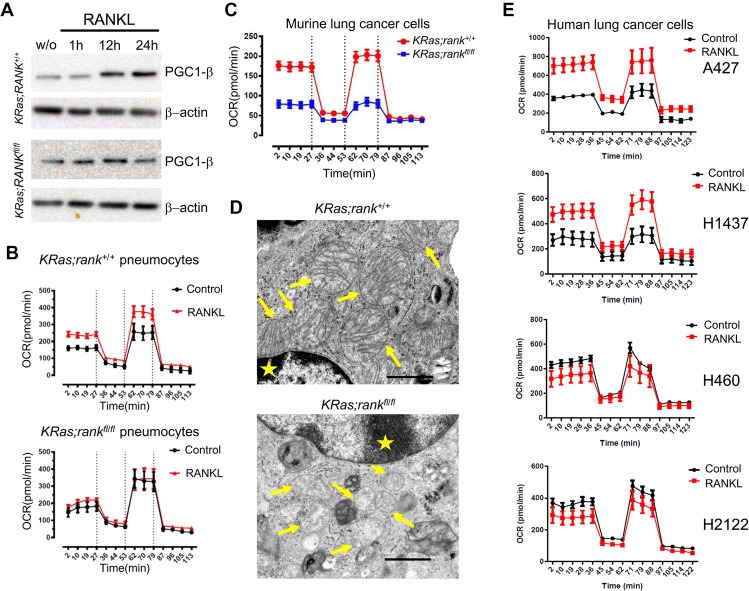
RANK couples to mitochondrial respiration. (A) Western blot analysis of pneumocytes isolated from KRas;rank+/+ and KRas;rankfl/fl mice treated for 96 h with AdCre to induce KRas and delete rank to determine the induction of the PGC1β protein in response to RANKL stimulation at the indicated time points. (w/o) Without any treatment control. (B) Bioenergetics profiling of primary pneumocytes isolated from KRas;rank+/+ and KRas;rankfl/fl mice. Purified pneumocytes were infected with AdCre to induce mutant KRas and delete rank in cells with rankfl/fl alleles; these cells were then treated with 1 µg/mL RANKL ex vivo for 24 h and, as controls, left without RANKL treatment. Of note, we already observed induction of oxidative phosphorylation (OXPHOS) at RANKL doses as low as 100 ng/mL. Oxygen consumption rates (OCRs) ± SEM were recorded to construct bioenergetics profiles using Seahorse. A minimum of five replicates was analyzed for each condition, and three different mice for each genotype were used independently. (C) Bioenergetics profiling of purified primary lung tumor cells from KRas;rank+/+ and KRas;rankfl/fl mice 18 wk after in vivo AdCre inhalation. Cells were treated with 1 µg/mL RANKL ex vivo for 24 h, and the assays used Seahorse. A minimum of replicates (OCR ± SEM) was analyzed for each condition, and purified primary lung tumor cells from three different mice were used independently. (D) Representative electron microscopy images for tumor tissues from KRas;rank+/+ and KRas;rankfl/fl mice 28 wk after AdCre inhalation. Note the relatively normal mitochondria with mostly intact cristae in control tumors in contrast to swollen mitochondria with notable cristolysis in rank mutant lung cancer cells (arrows). Stars indicate nuclei. Bars, 5 μm. (E) Bioenergetics profiling of the indicated RANKhigh-expressing human lung cancer cell lines A427 and H1437 and the two RANKlow human lung cancer cell lines H460 and H2122 in response to 1 µg/mL RANKL. Cells were treated with RANKL for 2 h, and OCRs (±SEM) were recorded for at least six replicates for each condition using Seahorse. X-axes show the recording times in minutes. Experiments were repeated independently three times.